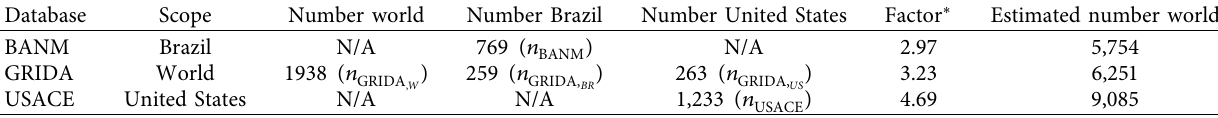
Table 1: Estimation of world tailings dams by the database used.